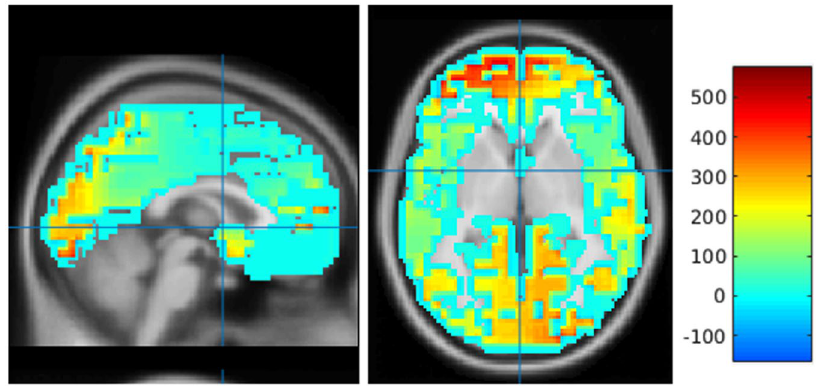
Figure 9. A 3D cortical distribution of the neuro-electrical generators of EEG alpha frequency band of a representative subject. The neuro-electrical generators computed using eLORETA is overlaid on a sagittal and axial slice of the MNI